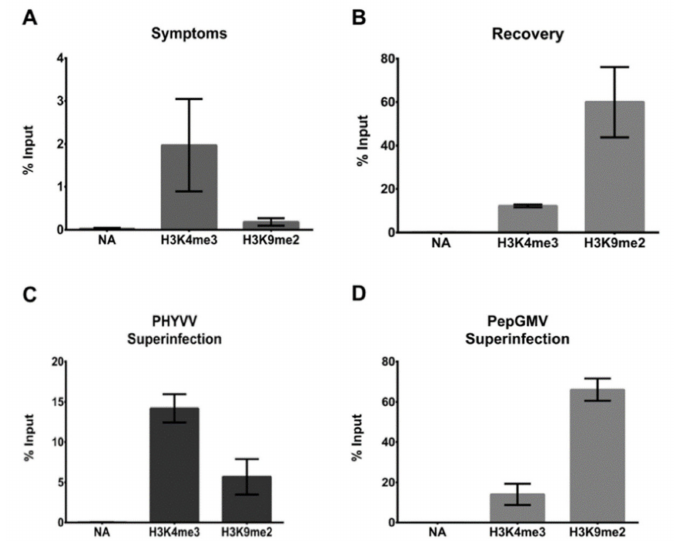
Figure 3. ChIP-qPCR analysis of the association of H3K4me3 (active) and H3K9me2 (repressive) histone marks with PepGMV minichromosomes. After minichromosome enrichment from symptomatic ( A ), recovered ( B ), recovered PHYVV-superinfected ( C ), or recovered PepGMV-superinfected ( D ) tissue, an immunoprecipitation assay was carried out using antibodies against H3K4me3 or H3K9me2, and pulled down viral DNA was quantified by qPCR using PepGMV IR specific primers. The data are presented as percentages of the input. Bars represent mean values of three independent biological replicates; error bars plotted refer to standard deviation of the mean. NA, no